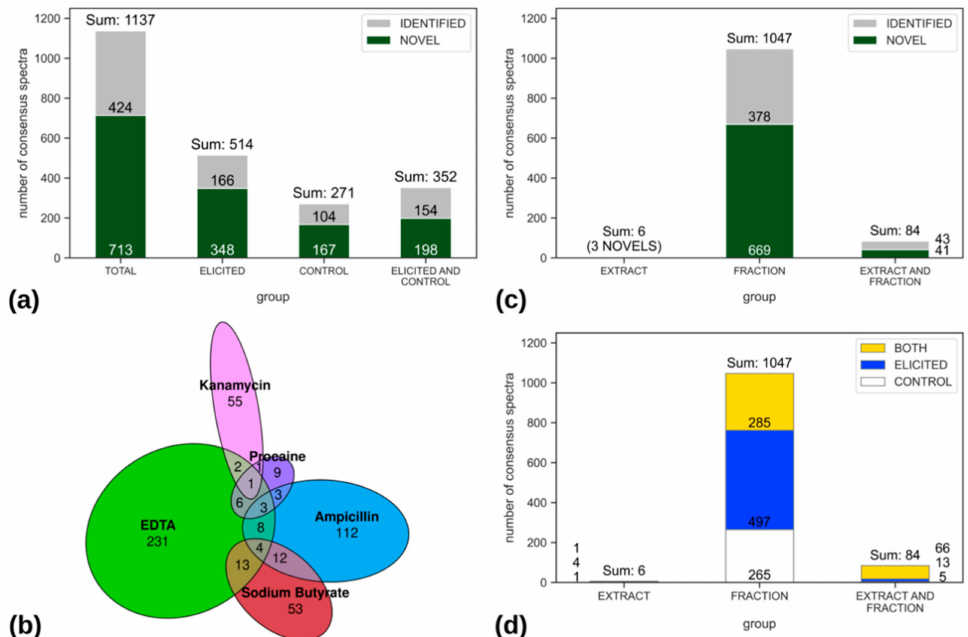
Figure 3. MS/MS consensus spectra distribution across the working groups reveals that the elicitation and fractionation strategies used for the bacterial chemical library construction increased the number and novelty of the metabolites detected by LC-MS/MS. ( a ) Distribution of total MS/MS consensus spectra related to [M + H]+ ions linked to bacterial metabolites (spectra related to chromatographic blanks, culture media and elicitors were excluded), in the different bacterial growth conditions: exclusively in the elicited conditions (elicited), non-elicited conditions (control) and in both elicited and control conditions. Bars are colored according to matches with databases (match = identified (grey), unmatched = potentially novel compound (green)). The cut-off for considering a spectrum as identified was MQScore ≥ 0.2, for the UNPD-ISDB (in silico), and MQScore ≥ 0.65, for GNPS (experimental) databases, with the MQScore ranging from 0 (totally dissimilar) to 1 (completely identical). ( b ) Euler diagram distribution of themetabolites detected exclusively under the elicited conditions: EDTA 10 mM, ampicillin 100 µ g/mL, sodium butyrate 50 µ M, kanamycin 100 µ g/mL and procaine 100 µ M. ( c ) Distribution of the metabolites detected exclusively in crude extracts (extract), fractions and both extract and fraction samples. Bars are color coded according to compound identification in databases—the same criteria used in ( a ) was applied. ( d ) Distribution of the metabolites detected in crude extracts, fractions and both extract and fraction samples, colored according to their detection in control (white), elicited (blue) or both (yellow—control and elicited) growth